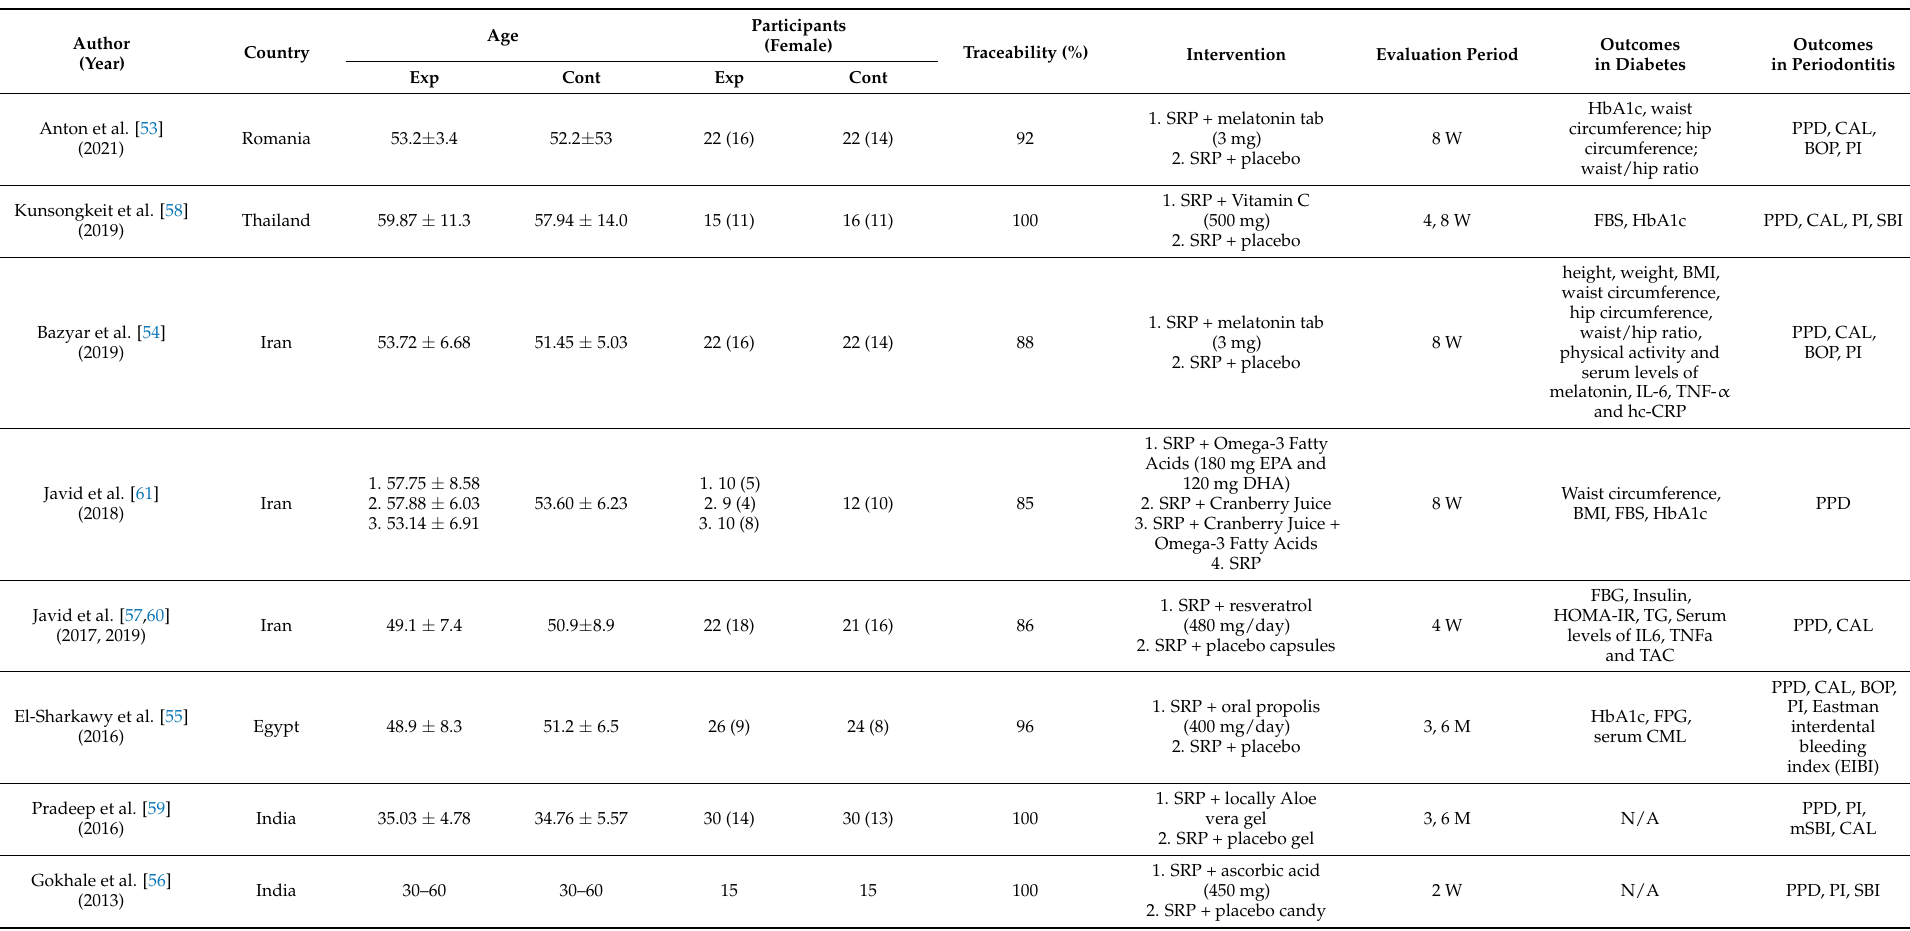
Table 1. Characteristics of the included